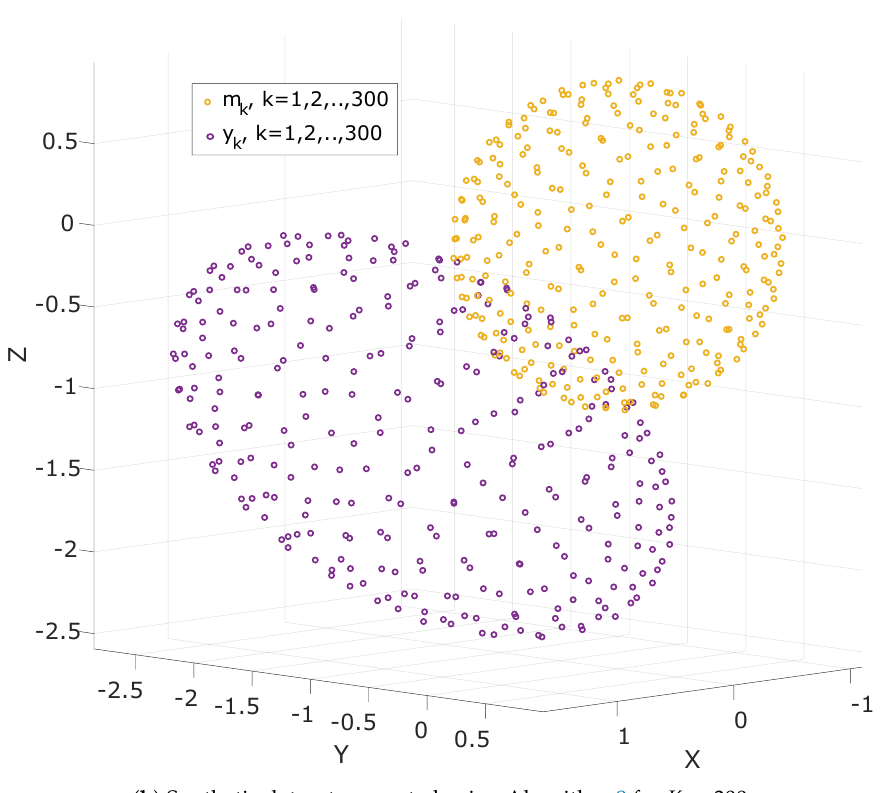
( b ) Synthetic dataset generated using Algorithm 8 for K = 300. Figure 1. Two synthetic datasets generated using Algorithm 8 for K = 150 ( a ) and K = 300 ( b ),